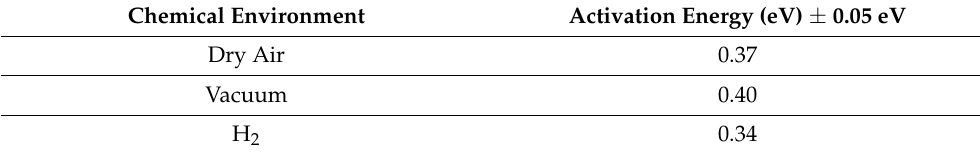
Table 2. The results from the VHR